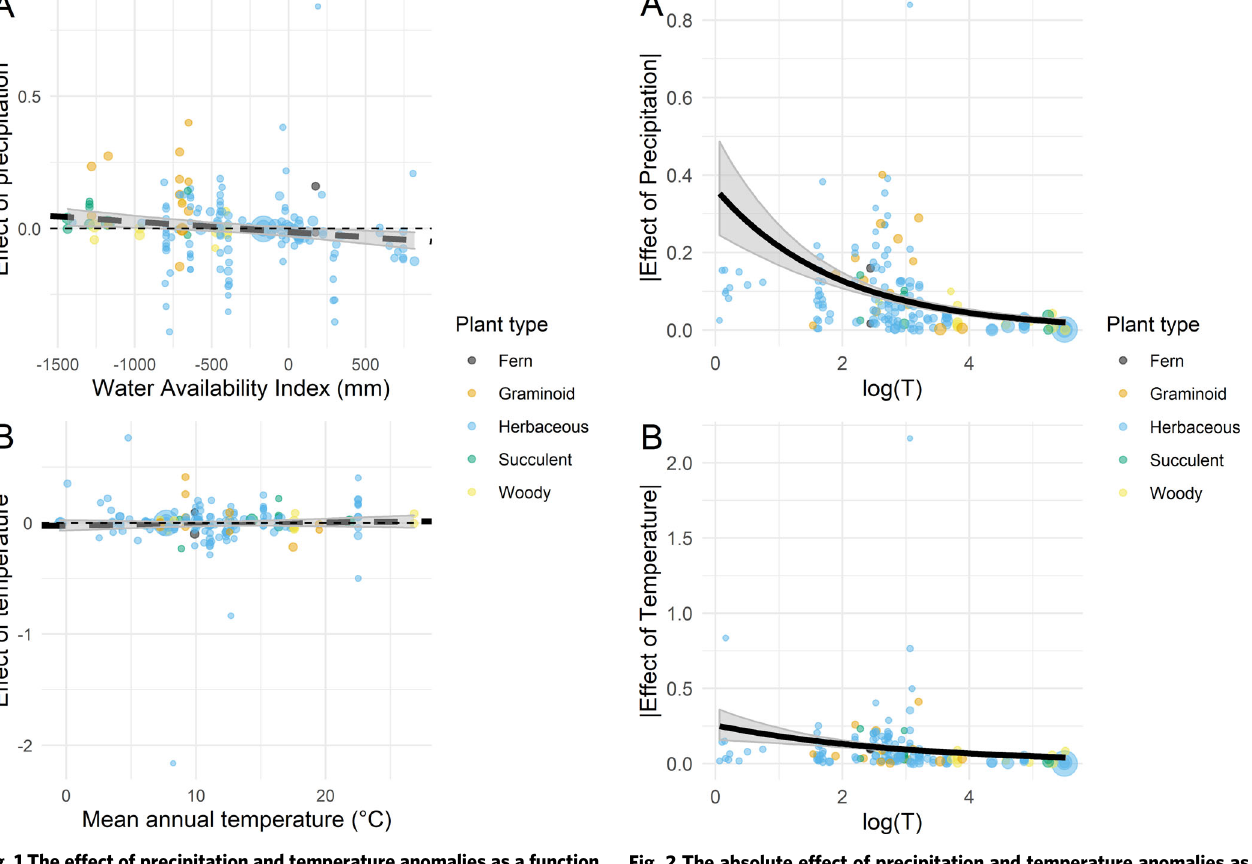
Fig. 2 The absolute effect of precipitation and temperature anomalies as a function of logged generation time ( T ). We show the effect sizes of precipitation and temperature anomalies as a function of log( T ) (panels A and B , respectively). The uncertainty of these effect sizes is shown by the size of circles, which are inversely proportional to the standard error (SE) of effect sizes (1/SE). The thick black lines show the mean prediction of the meta -regressions. The shaded areas represent the 95% con fi dence interval of 1000 bootstrapped gamma regressions. The color of individual data points shows fi ve separate plant